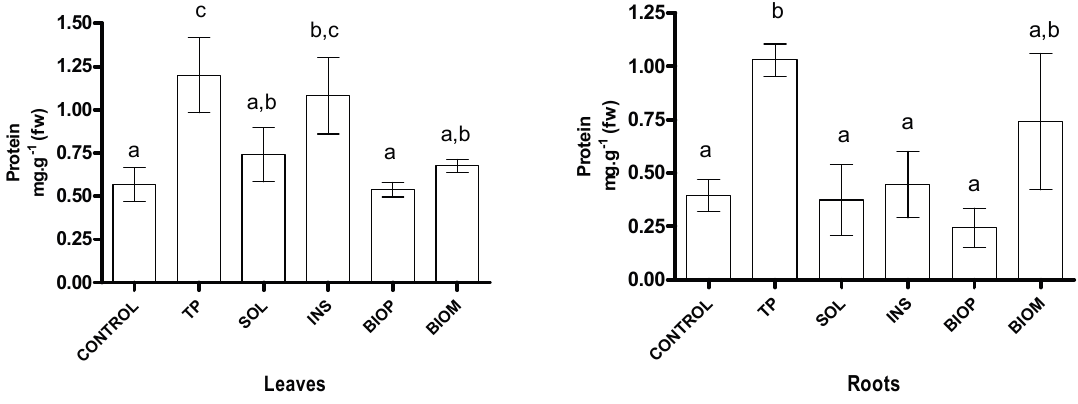
Figure 4. Plant protein content. Values are the mean of three replications with standard deviation. Letters in columns indicate statistical significance—samples not sharing a letter differ significantly at p <